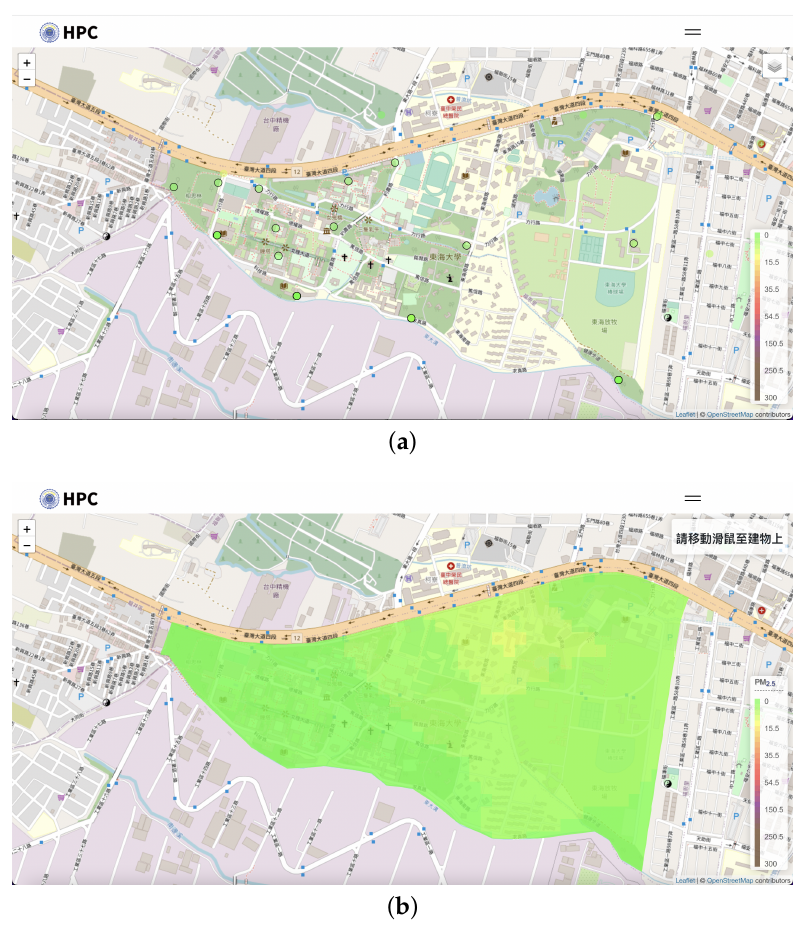
Figure 13. LoRa Map and IDW coverage: ( a ) The location map of monitoring stations; ( b ) IDW map implementation.